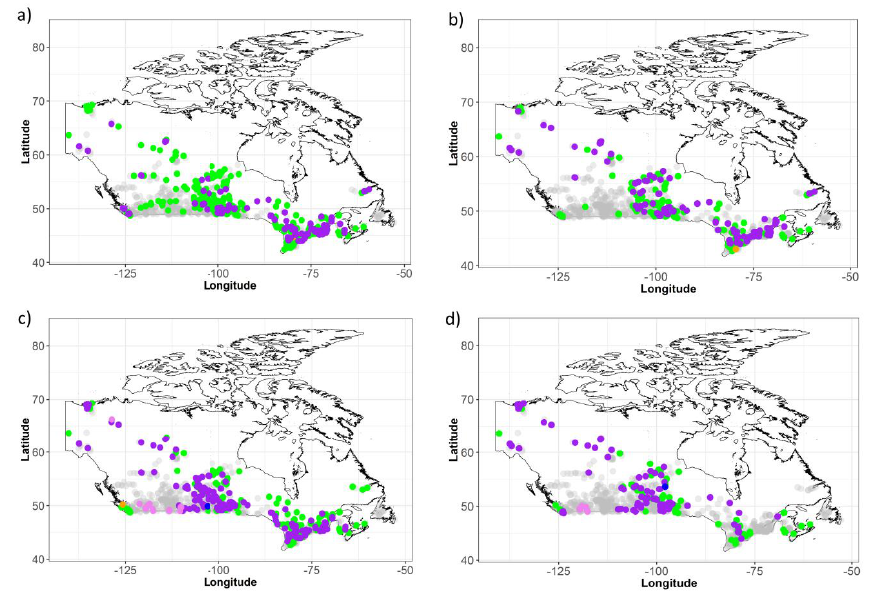
Figure 7. The change in flood timing obtained from robust GCM median approach at FRIs under ( a ) RCP 2.6, ( b ) RCP 4.5, ( c ) RCP 6.0, and ( d ) RCP 8.5. FRIs projected with no change in flood timing are shown in green. FRIs projected with earlier occurrences of floods are shown in shades of blue (purple for 1 month shift, blue for 2 months shift, and dark blue for 3 month shift). FRIs projected with later occurrences of floods are shown in shades of orange (1–3 month shifts shown in light to dark orange). FRIs where 4 or more months of changes (in either direction) are projected, are shown in pink. Finally, FRIs projected with uncertain flood timing in either historical or future timelines are shown in